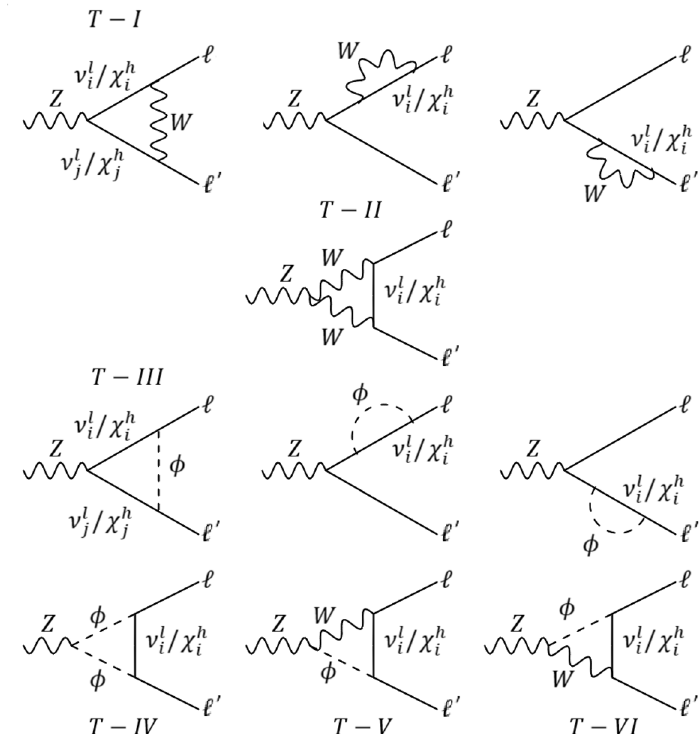
¯ ‘‘ decays. Diagrams corresponding to